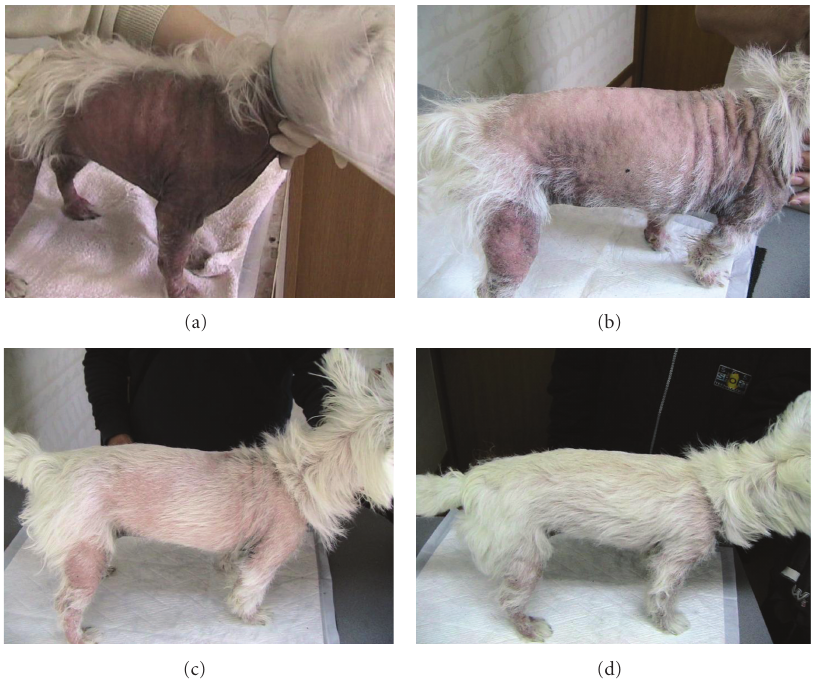
Figure 2: Clinical characteristics of Dog 5 at start of the treatment (D0), 6 weeks after D0, and 12 weeks after treatment are shown in Figures 2(a), 2(b), and 2(c), respectively. Progressive changes in disease severity were seen in the 12-week trial period. The dog was treated continuously after the completion of the trial. Clinical symptoms improved 18 weeks after D0 (Figure